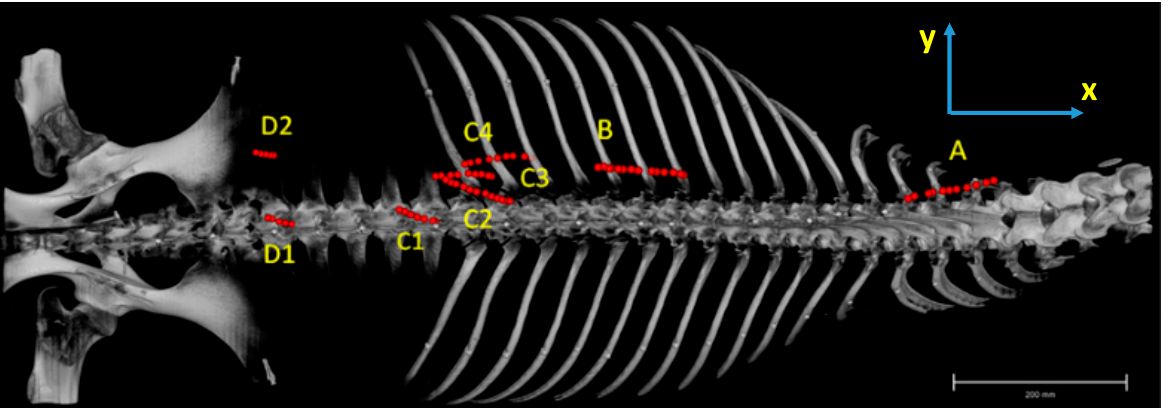
Figure 7. Dorsal view of a rendered CT bone model of a horseback. Red lines demonstrate the orientation (to the sagittal plane) of one representative fascicle for each compartment and sub-compartment (yellow letters) for the left longissimus dorsi muscle.